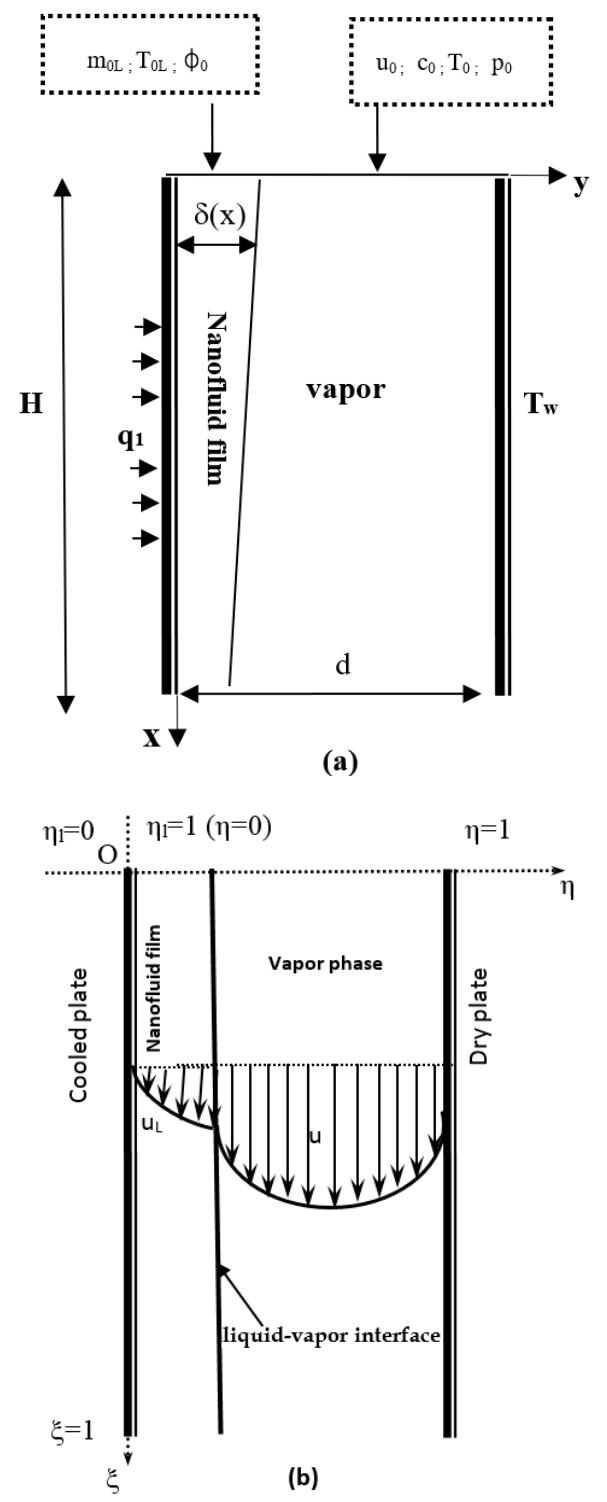
Figure 1. ( a ) Schematic diagram of physical system of heat exchanger. ( b ) Domain of the physical system of heat exchanger.